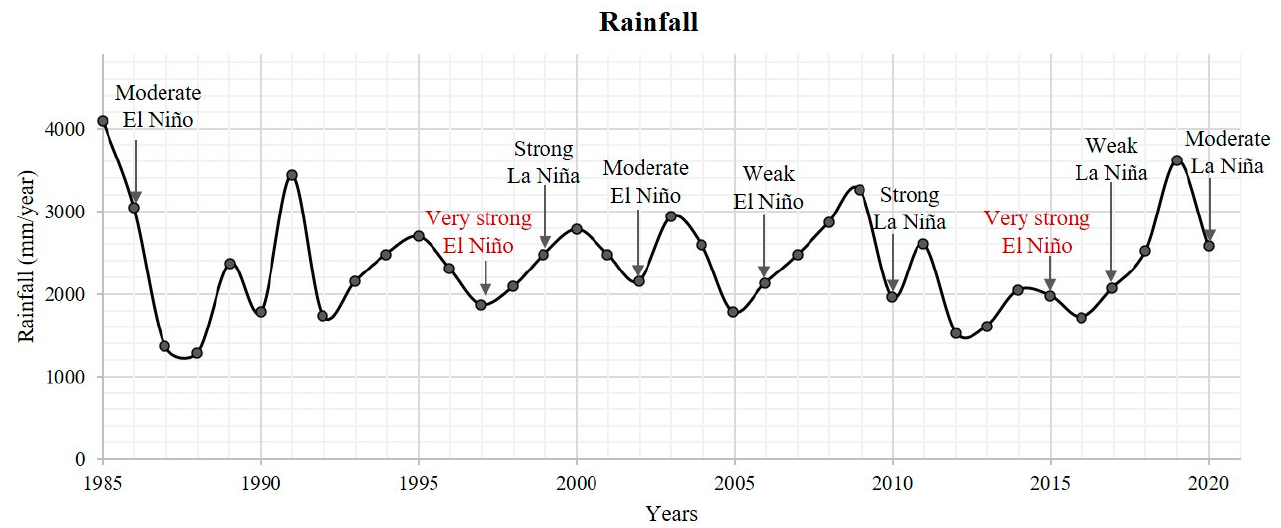
Figure 13. Annual precipitation values in the Bragança peninsula (mm) with the “El Niño” and “La Niña” phenomena for the analyzed scenes [58,59].